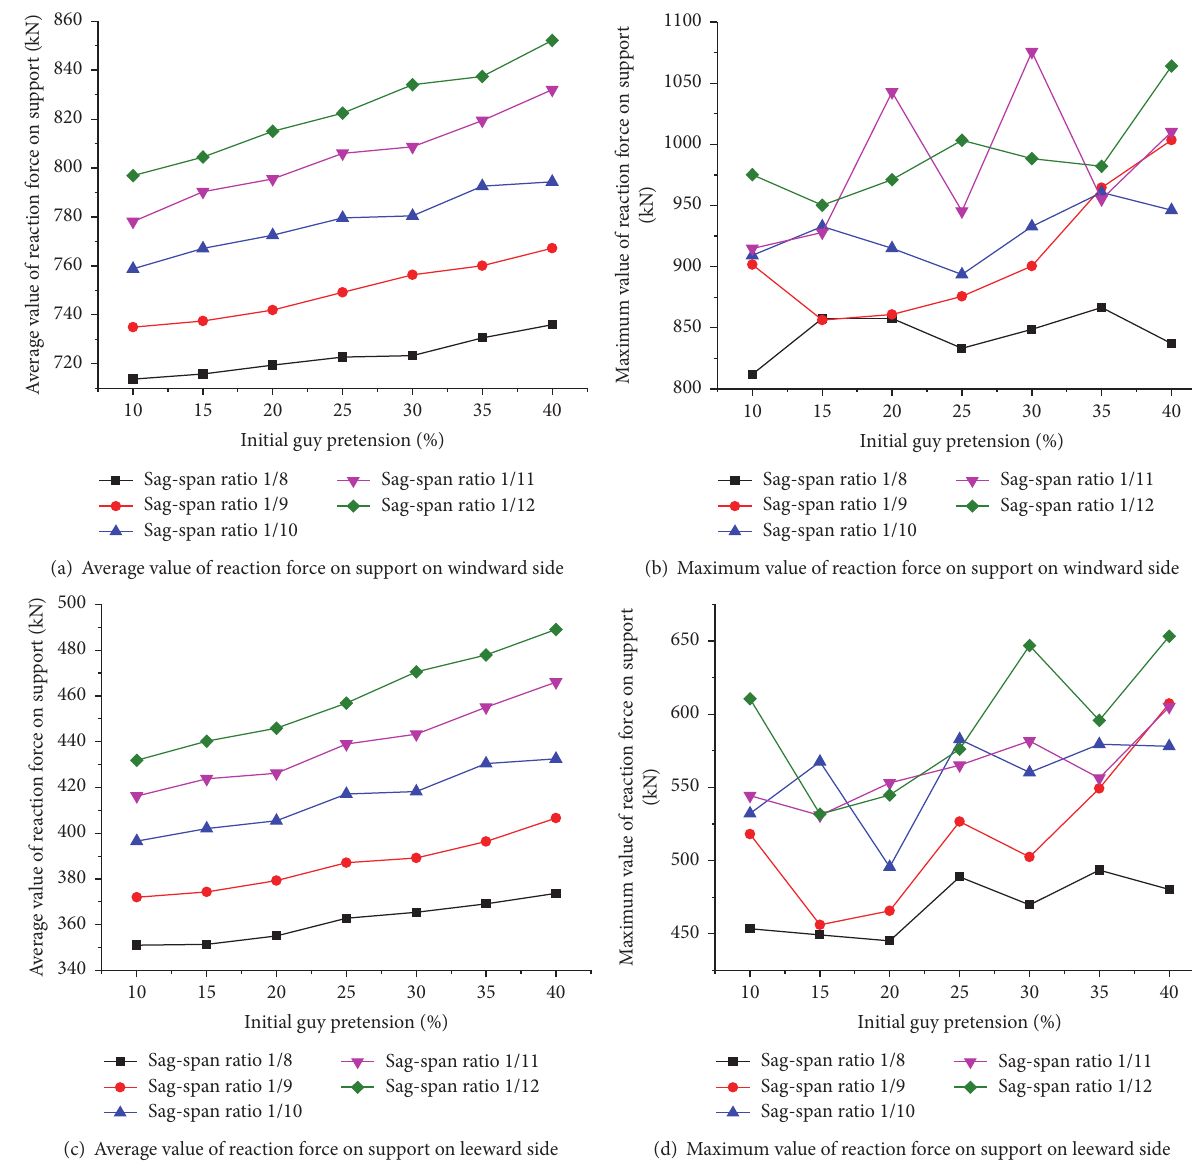
Figure 7: Effect of initial guy pretension and sag-span ratio on